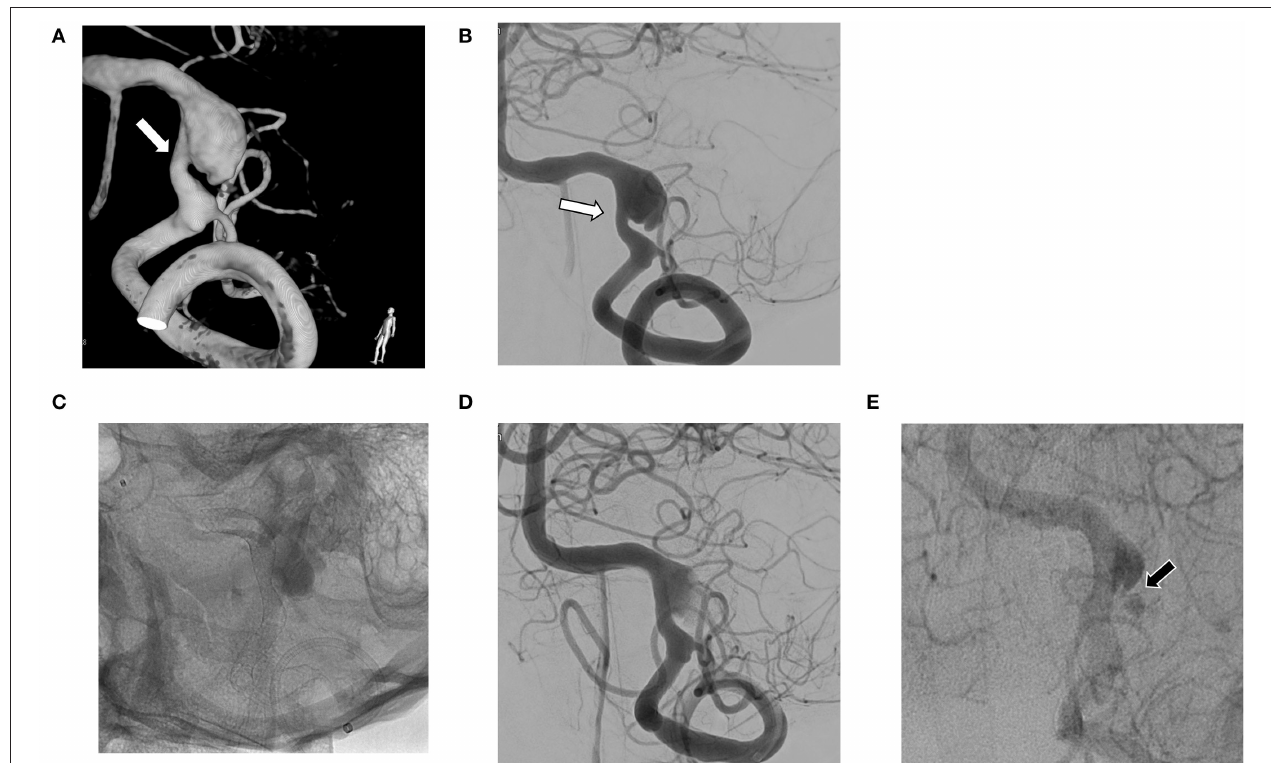
FIGURE 2 | (A,B) Vertebral artery dissecting aneurysm (VADA) combined with fusiform dilation and stenosis (white arrow); (C,D) The flow diverting stent deployed at the VADA fully covers the lesion; (E) Small residual neck and delayed sac filling (black arrow) at 6 month follow-up